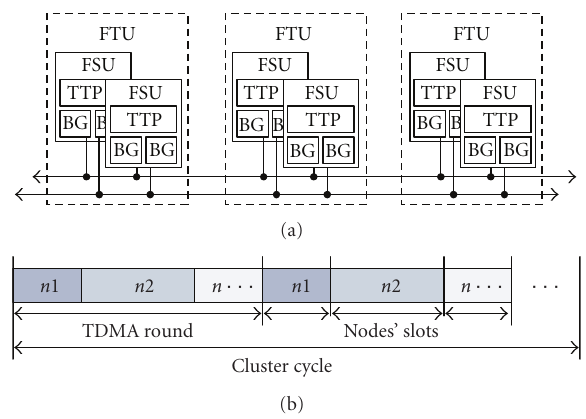
Figure 1: TTP system structure (a) and TDMA communication scheme